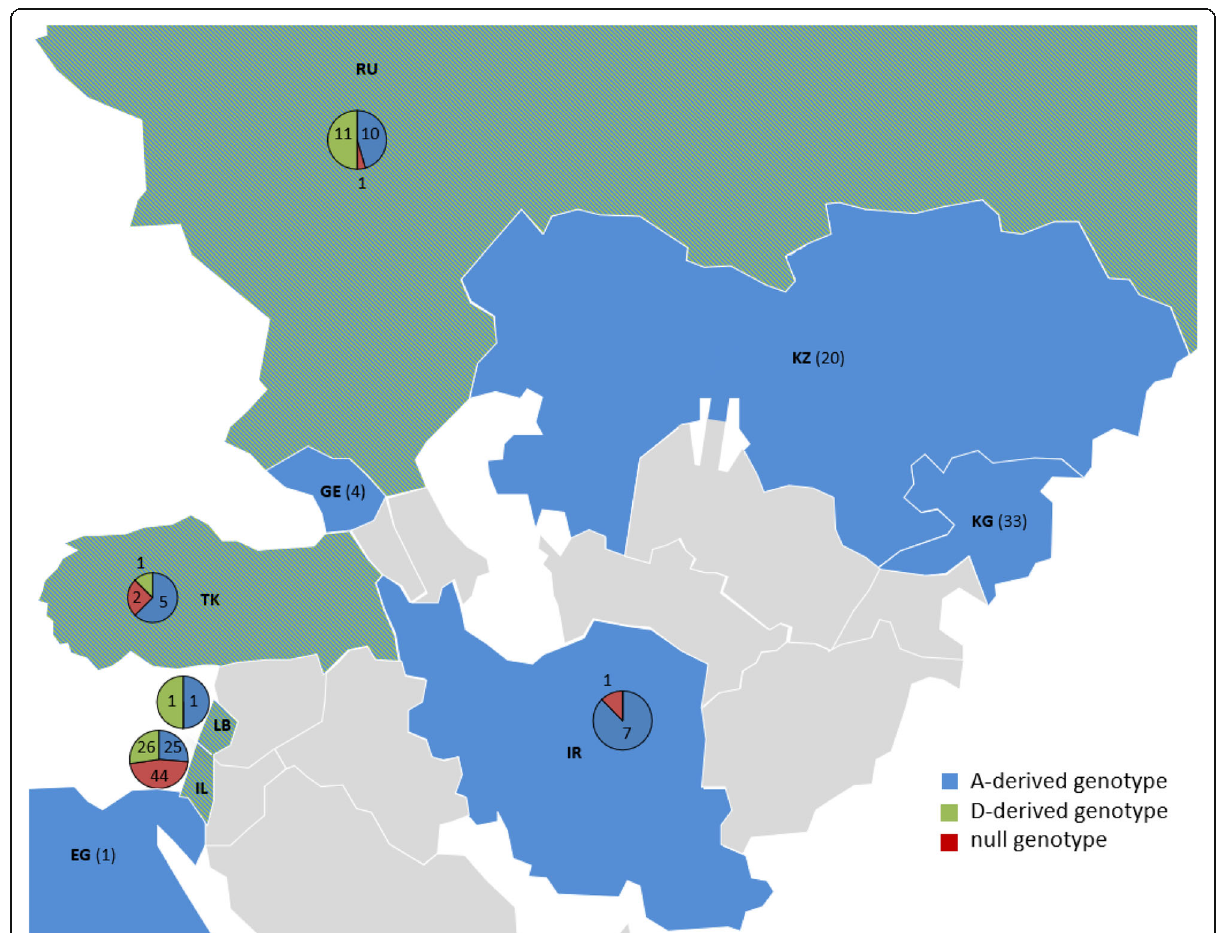
Fig. 4 Prevalence of archetypal genotypes A (blue) and D (green) in the Mediterranean Area, Russia, and Asia in the timeframe 1982 – 2019. Pie charts denote the number of isolates of each genotype recovered in each country. If only one genotype was detected, the number of corresponding isolates is indicated between parentheses after the country code. Countries are colored according to the predominant archetypal genotype if this was retrieved in a fraction exceeding 90%, else they are shown in petrol blue. The null PCR genotype is indicated in